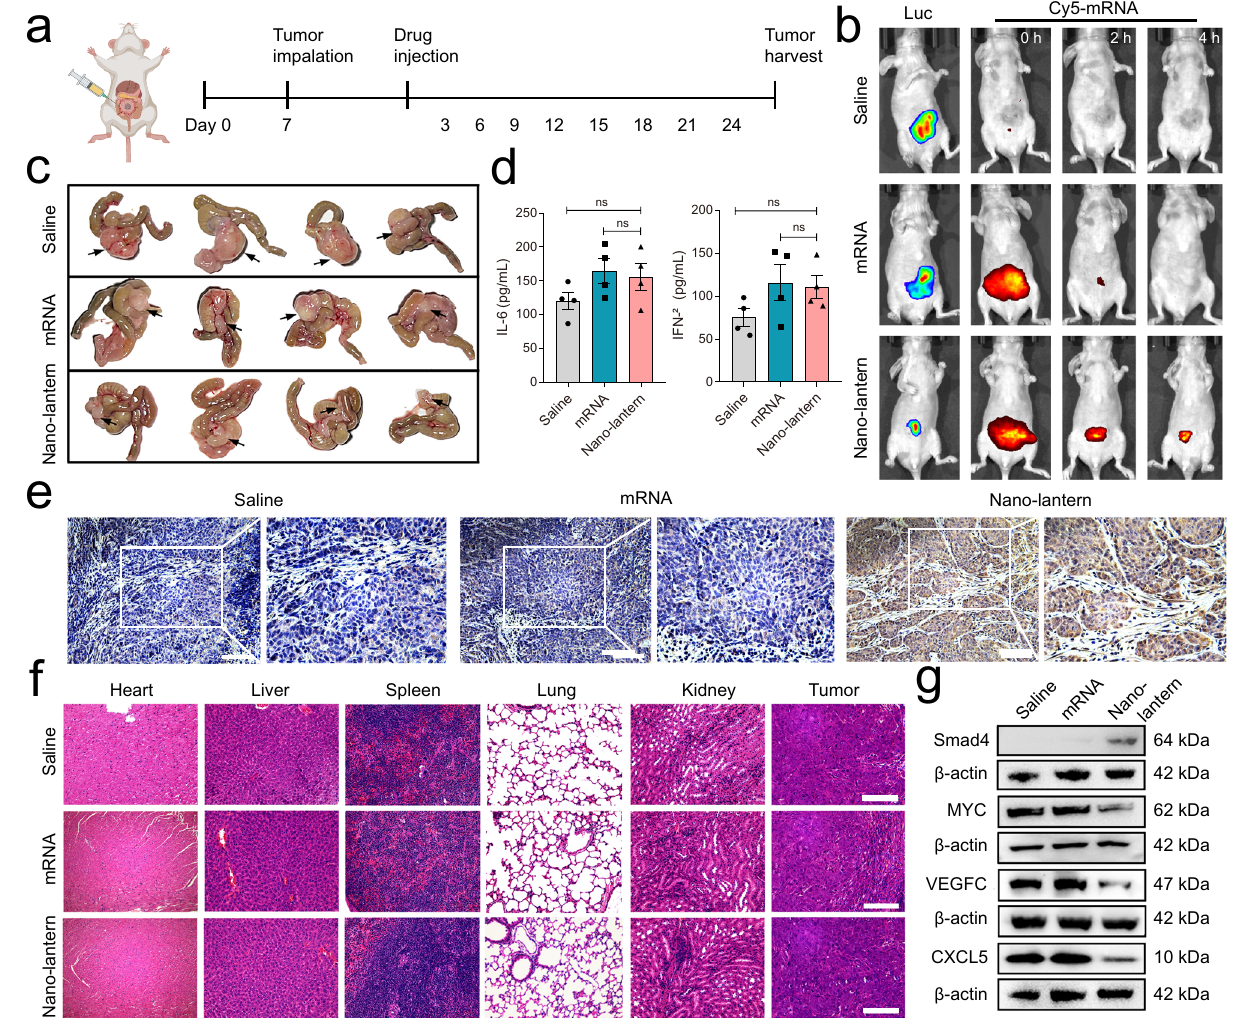
Fig. 9 | The tumor suppression of mRNA nano-lantern in an orthotropic cecal injection model. a Systematic schedule of Smade4 mRNA nano-lantern adminis- tration in the orthotopic model of SW480-Luc cells. Created with BioRender.com. b Representative bioluminescence imaging of tumor burden and fl uorescence imaging of Cy5-mRNA nano-lantern in tumor-bearing nude mice. c Ex vivo images ofthexenografttumorsattheendpoint. d IL-6andINF- β levelsinperipheralblood of tumor bearing mice after 6h post-intraperitoneal injection of different for- mulations ( n =4 mice/group). e Representative IHC staining for Smad4 in tumor